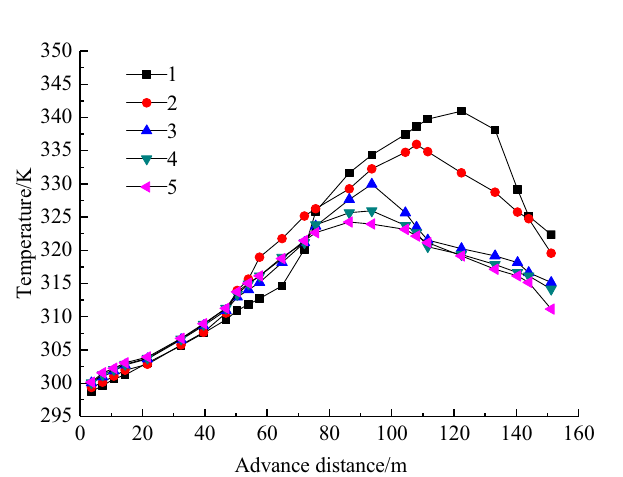
Figure 3. Law of temperature change of each measuring